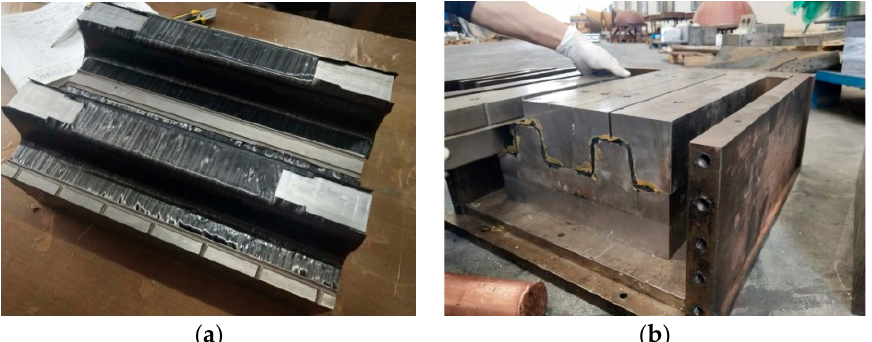
Figure 7. CFRP laminates on the molds and the closed molds: ( a ) laying up the prepreg; ( b ) closing the molds.